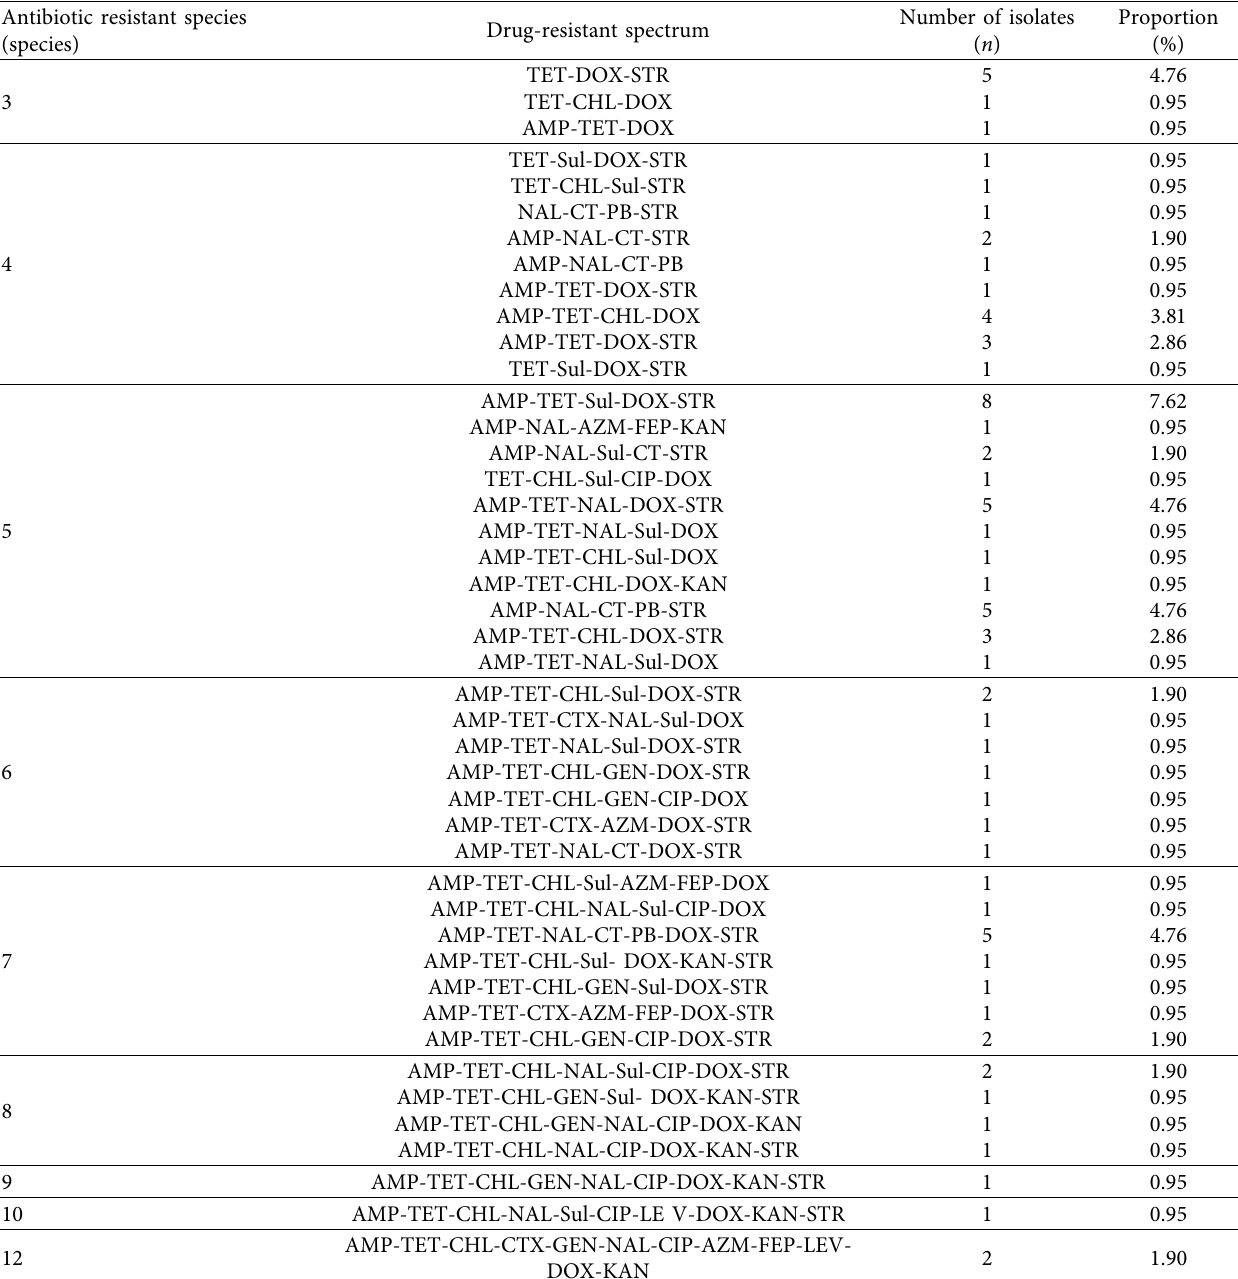
Table 3: Drug resistant spectrum of 105 Salmonella strains collected from 2018 to 2020 in six sentinel hospitals from Huzhou, Zhejiang,